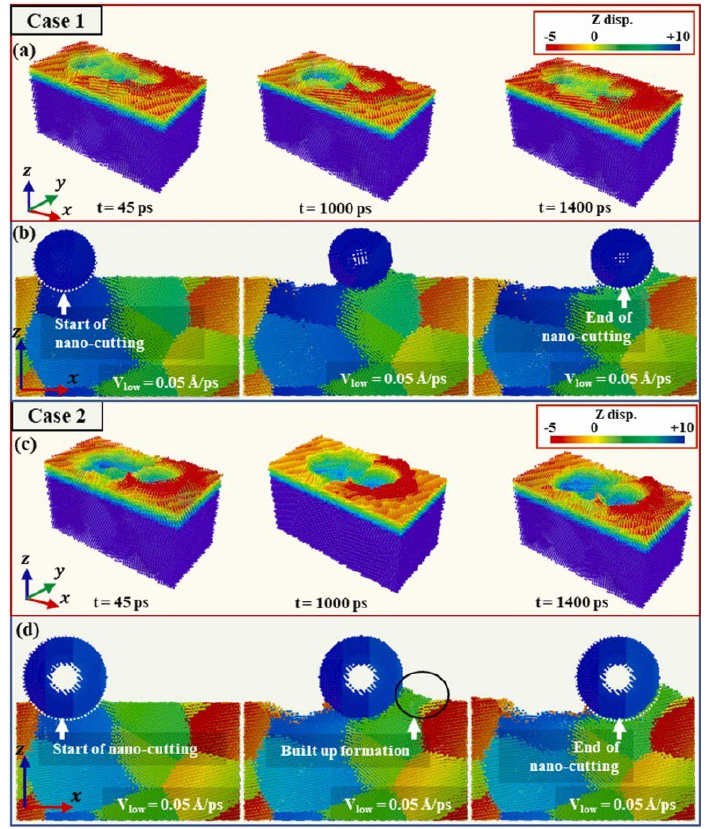
Figure 37. (Nano-cutting process on p-Cu work material for cases ( a , b ) 1 and ( c , d ) 2 at Vlow. ( a ) and ( c ) atoms are colored in the z-direction to visualize the material removal during nano-cutting. ( b ) and ( d ) atomistic models of sectional views for start position, mid-position, and end position of abrasive during cutting at Vlow [199].